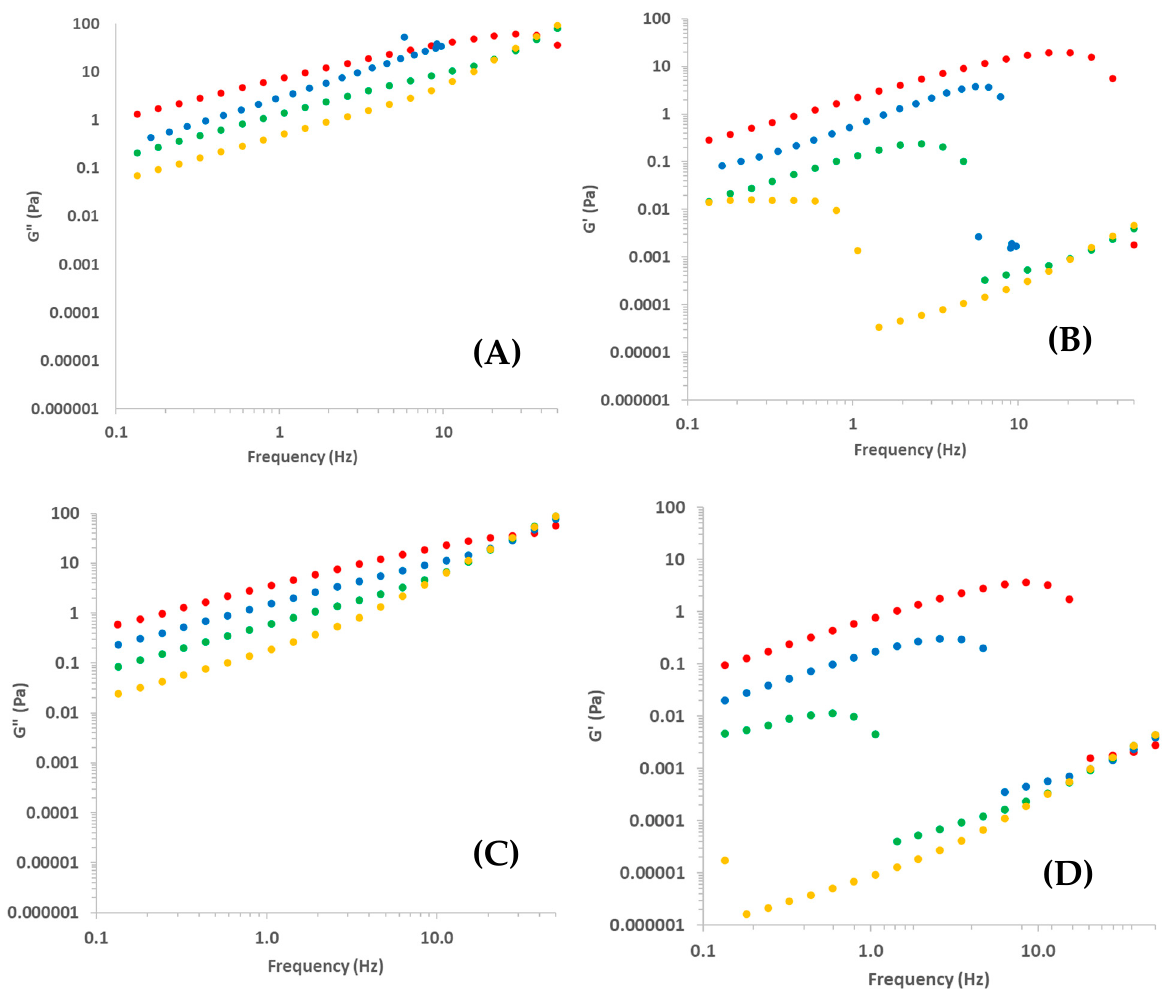
Figure 6. Loss (G”, A , C ) and storage (G’, B , D ) moduli determined by frequency sweep tests of chitosan solutions prepared with several chitosan concentrations: 2.5 (red), 2.0 (blue), 1.5 (green), 1.0 (yellow); at 25 ( A , B ) and 45 °C ( C , D ).